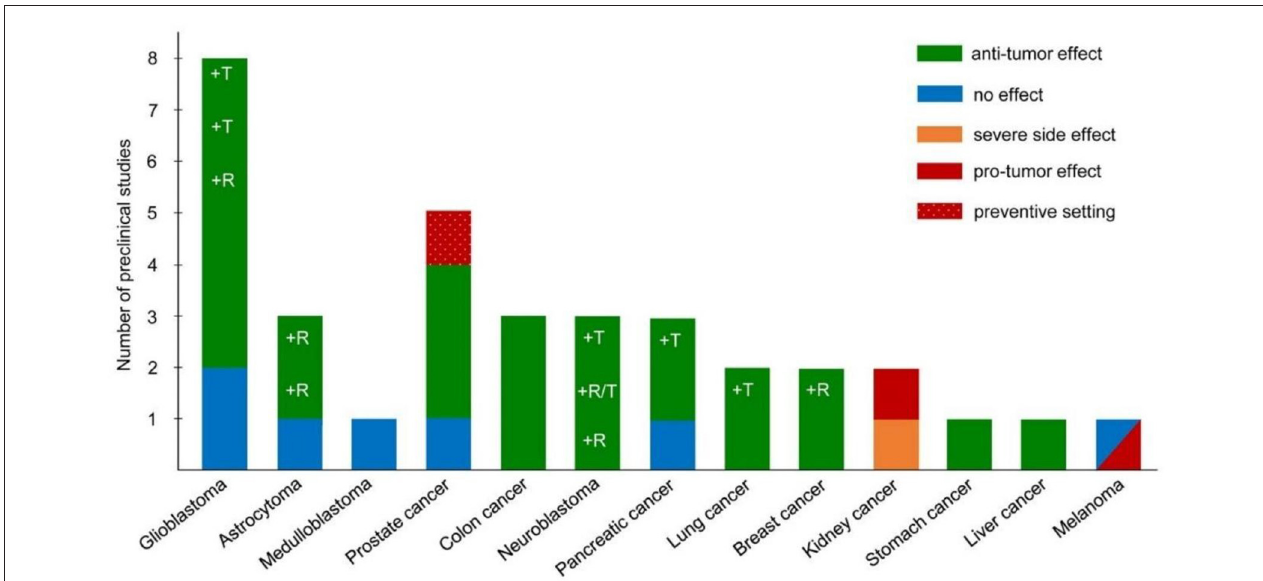
FIGURE 2 | Pre-clinical studies on the ketogenic diet as antineoplastic therapy, adapted (29).